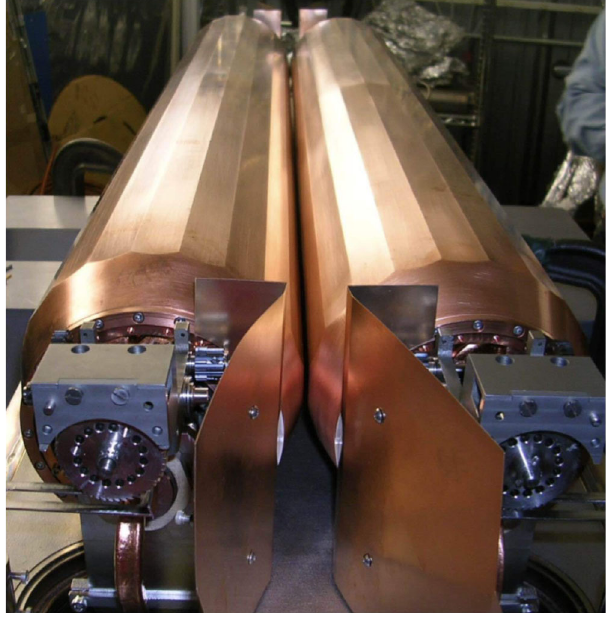
FIG. 1. Beam view of the rotatable collimator prototype with the tank